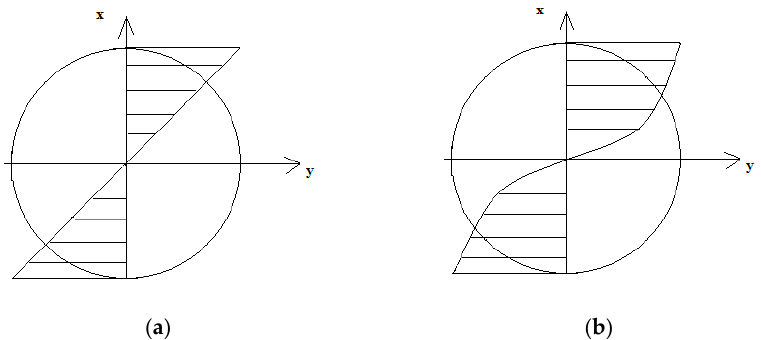
Figure 3. The distribution of ( a ) 𝜀 strains and ( b ) σ elastoplastic stresses under bending.